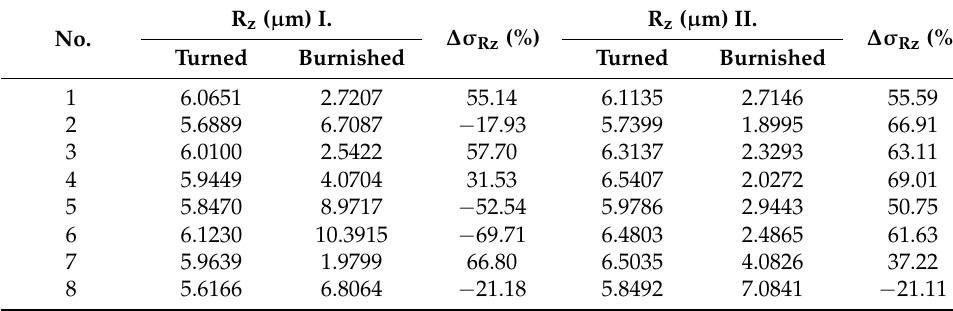
Table 6. The measured values and the calculated improvement ratios for R z .